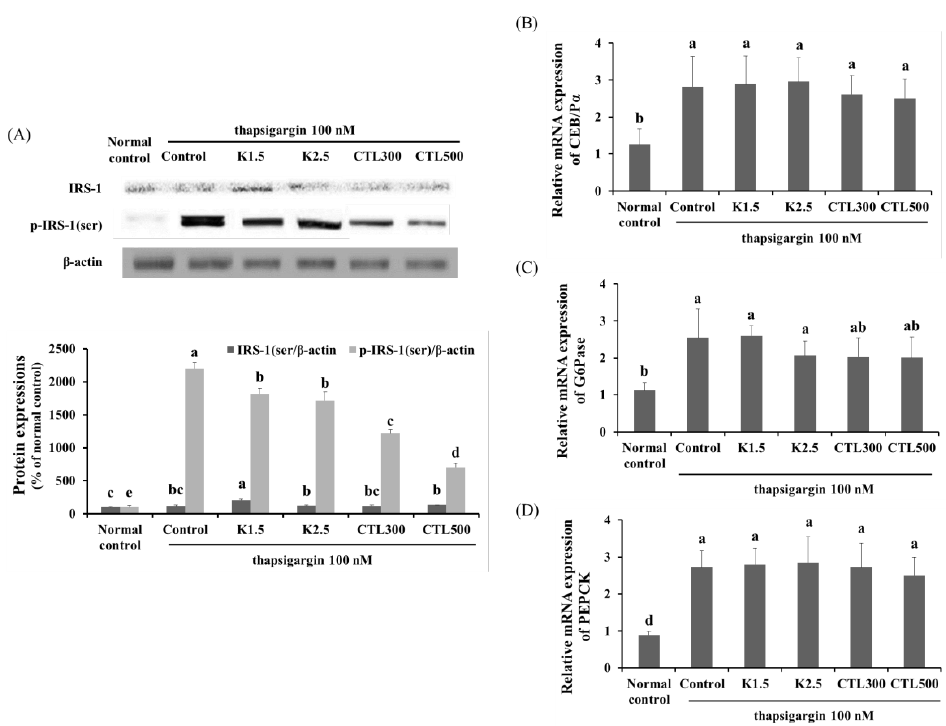
Figure 5. Effect of CTL and kaempferol on gluconeogenesis and insulin resistance in thapsigargin-induced HepG2 cells. ( A ) Representative Western blots for total protein and serine phosphorylation of IRS-1 in thapsigargin-induced HepG2 cells with CT water extract or kaempferol; mRNA expression of ( B ) C/EBPα, ( C ) PEPCK and ( D ) G6Pase in thapsigargin-induced HepG2 cells with CT water extract or kaempferol. The data are expressed as the mean ± SD ( n = 3). The different letters show a significant difference at p < 0.05 as determined by Duncan’s multiple-range test.